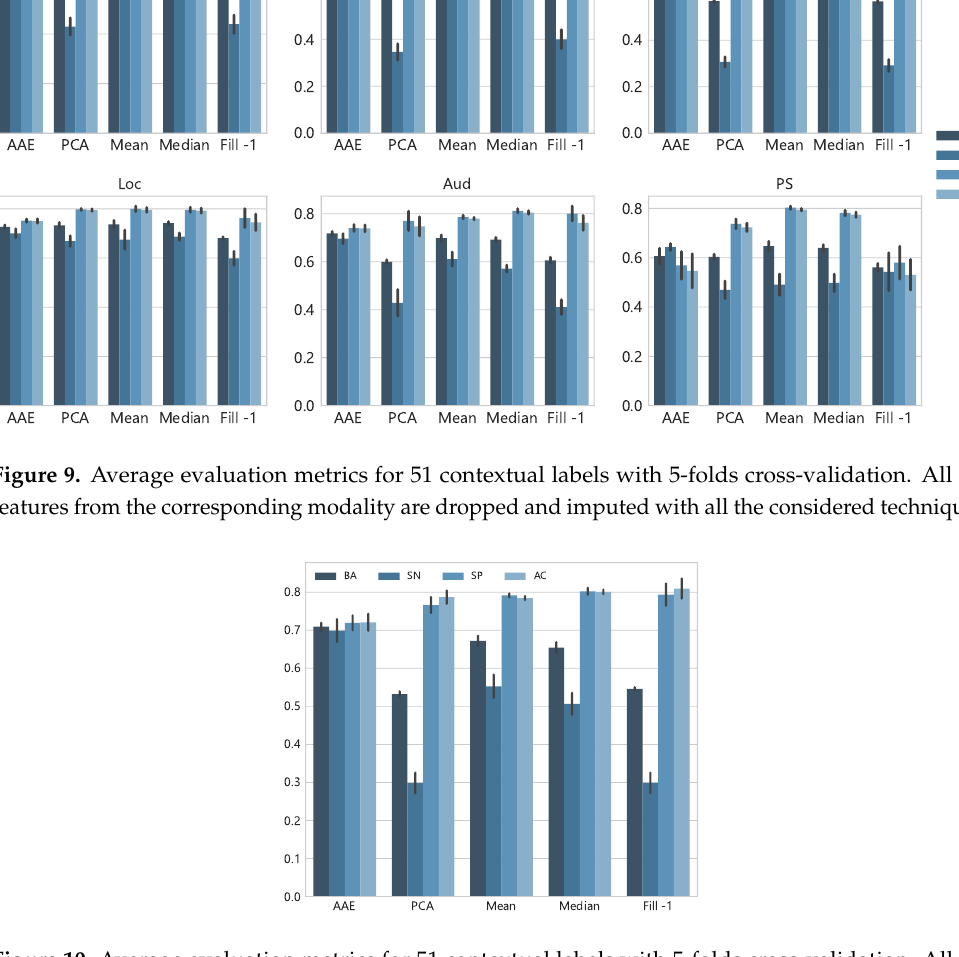
Figure 10. Average evaluation metrics for 51 contextual labels with 5-folds cross-validation. All the features from Acc , Gyro and Aud modalities are dropped and restored with a specific